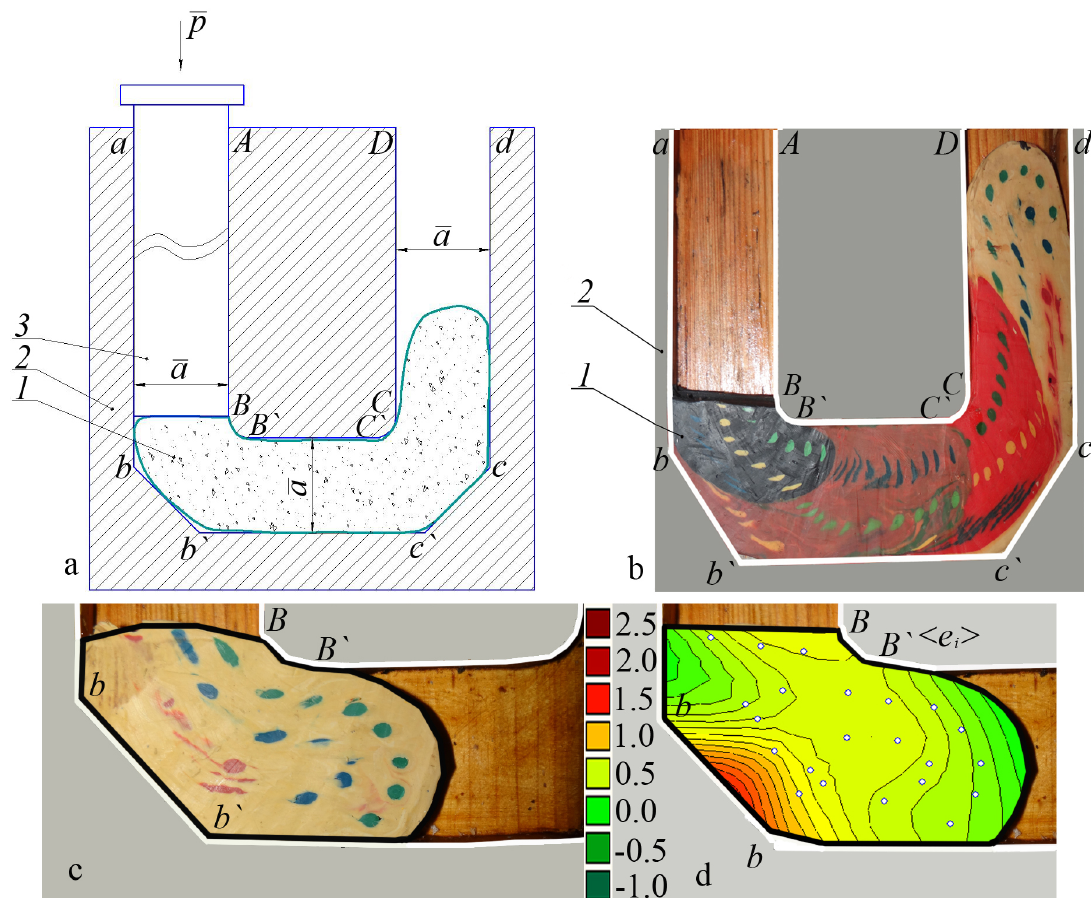
Fig. 1. ECMAE schemes of a truncated U-shaped die (1 – workpiece; 2 – split die; 3 – punch): (a) – scheme of the flow of the workpiece; (b) – workpiece physical model with the initial circular gridlines at the final stage of filling the outlet channel cdCD of the U – shaped die; (c) – the soft physical model of deformable workpiece with the initial circular gridlines at the initial stage of filling the transition channel bb’BB’ of the U – shaped die; (d) – the experimentally-theoretical field of logarithmic strain intensities for the one-component model (c).